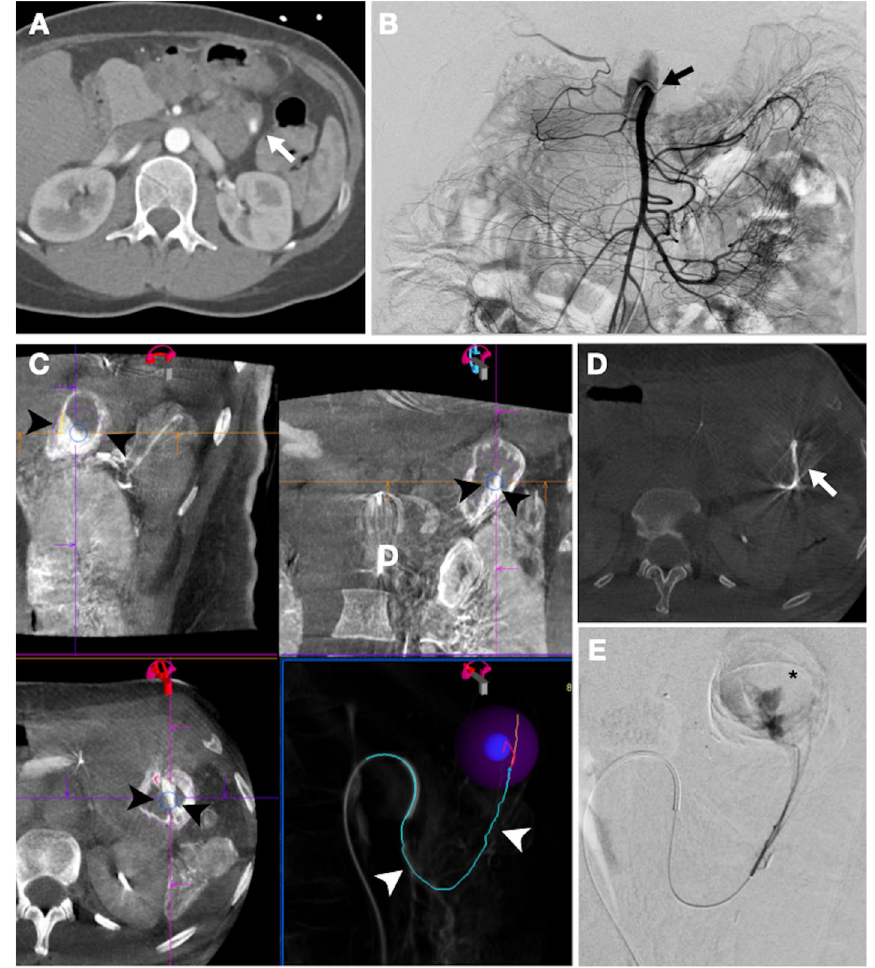
Fig. 2 Empiric TAE approach in patient 2 A Pre-procedural arterial-phase CTA displays a contrast extravasation proximally in the Roux-en Y jejunal loop (white arrow). B No bleeding focus on subsequent DSA with contrast injection in the superior mesenteric artery (black arrow). C